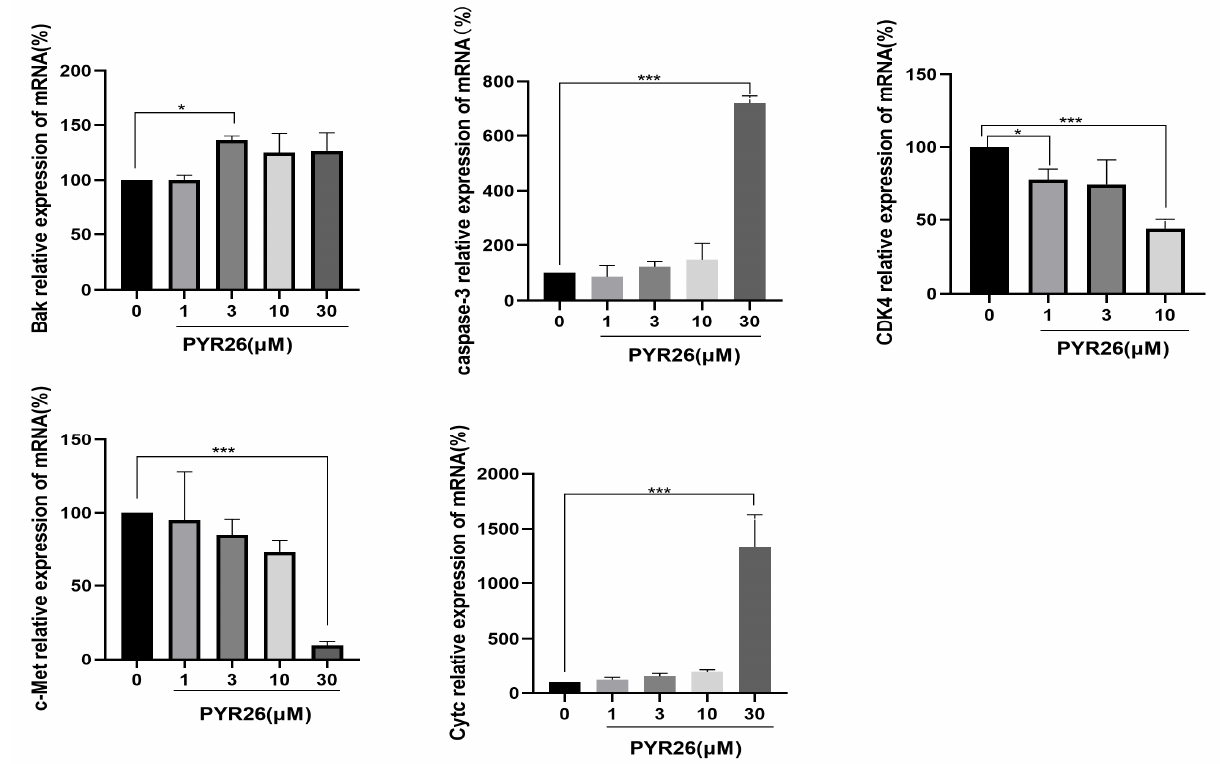
Figure 5. The expression of c-Met, CDK4, Cytc, Bak and caspase-3 genes in HepG2 cells influenced by PYR26 for 24 h (* p < 0.05, *** p < 0.001 vs. control group).